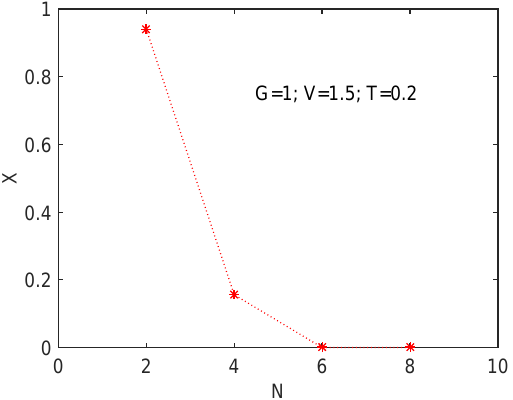
Figure 4. The N dependence. Superconductivity indicator X versus N for V = 1.5 (greater than V crit ) and pairing force G = 1 (the critical one at T = 0). We have T = 0.2 here. The pairing effects’ intensity abruptly falls as N